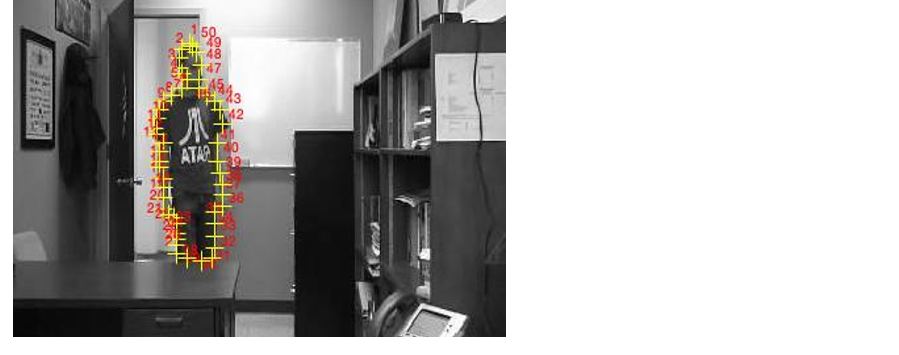
Figure 5. Example of marking with 50 characteristic points (landmarks) in the PDM stage of the office scene (frame 23) of CDnet 2014.